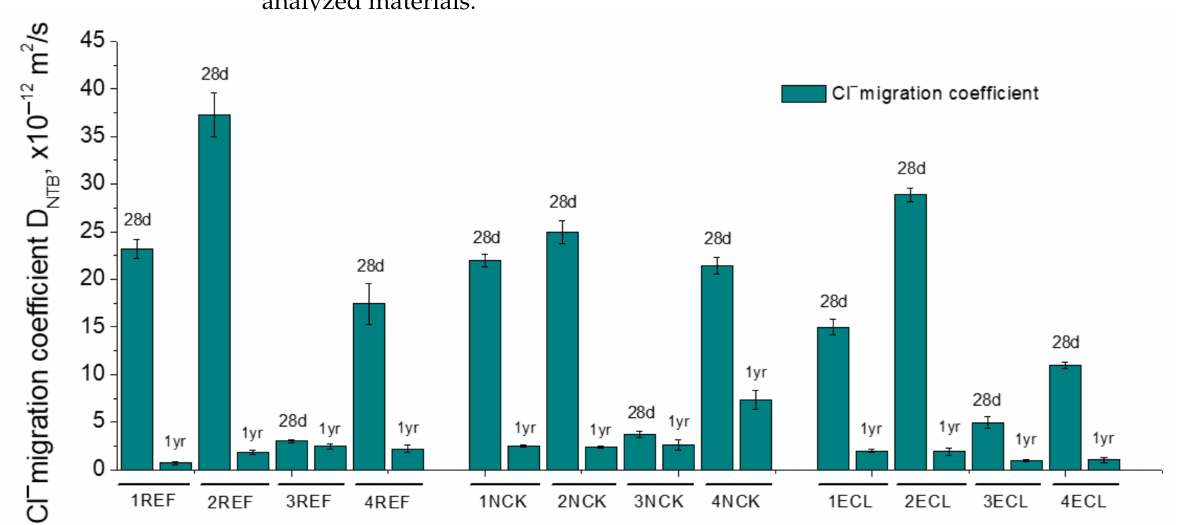
Figure 6. Non-steady-state chloride migration coefficient results for the series